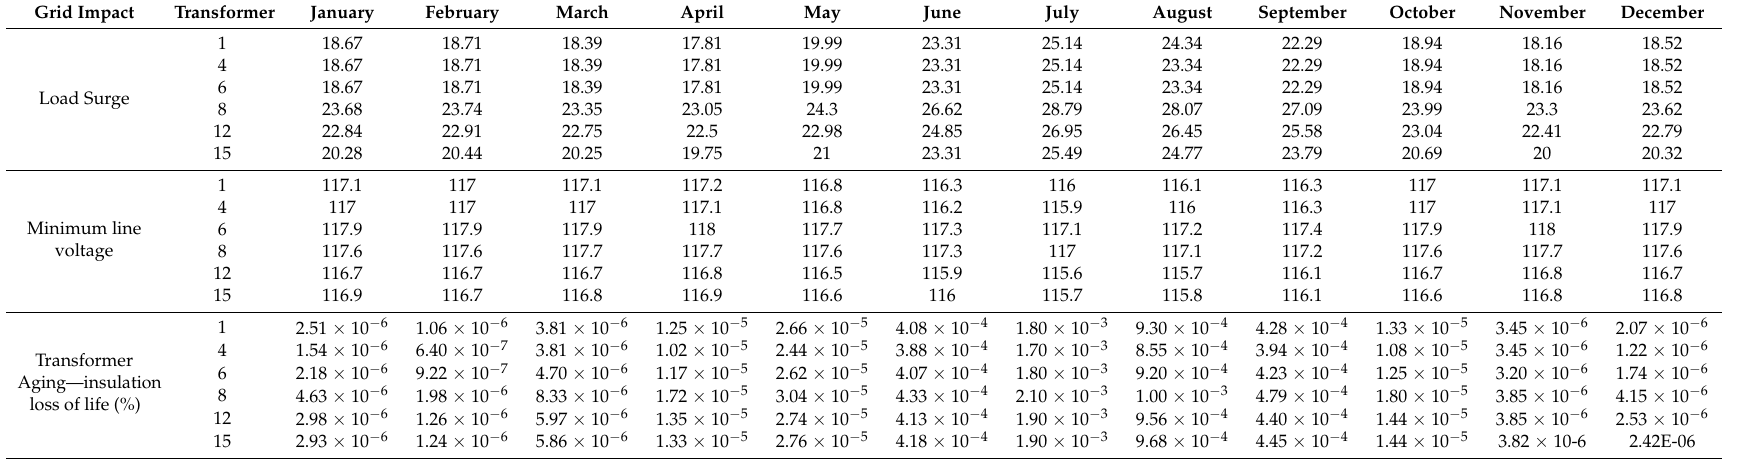
Table A3. Summary of the impact of ToU + DLC PEV charging in 12 months.